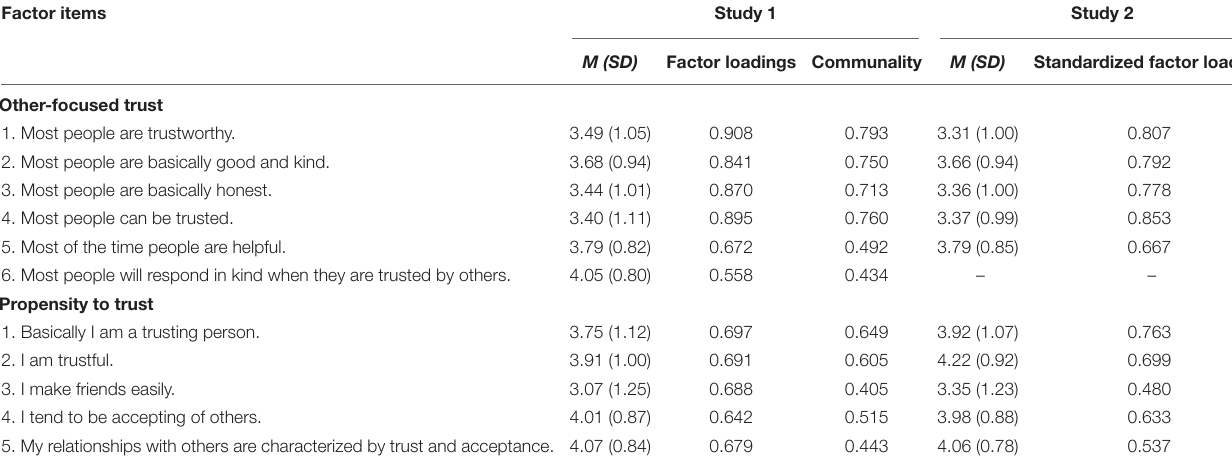
TABLE 4 | Factor loadings for the items in Study 1 and Study